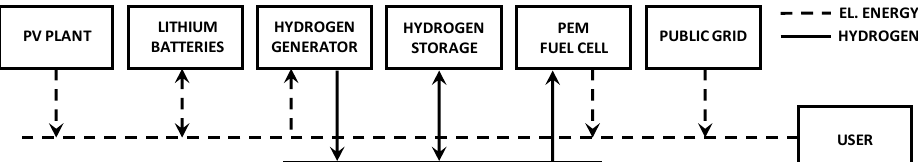
Energies 2020 , 13 , x FOR PEER REVIEW Figure 2. Schematic of the hydrogen-based microgrid. Figure 2. Schematic of the hydrogen-based microgrid.